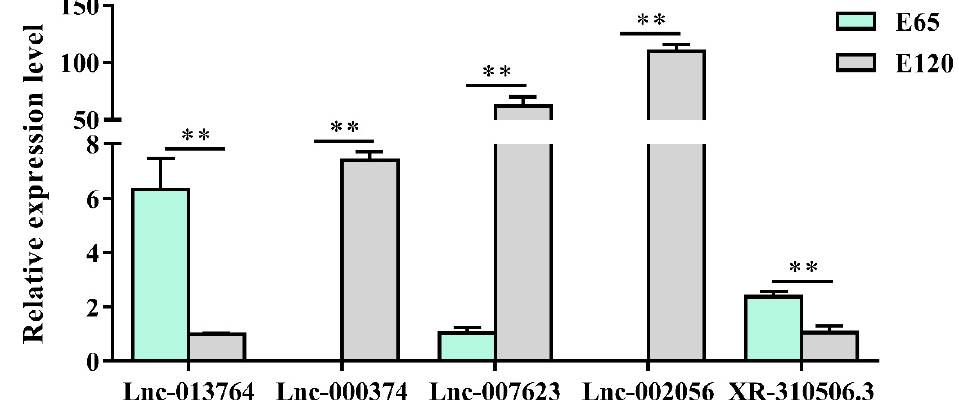
Figure 7. The lncRNA expression patterns in different stages. The results were in accordance with the RNA-seq data and showed that lnc_000374 and lnc_002056 were specifically expressed at E 120. The expression of specific genes was quantified relative to the expression level of β -actin using the comparative cycle threshold ( ΔΔ CT) method. The data are expressed as the mean ± SE ( n = 3). ** p <